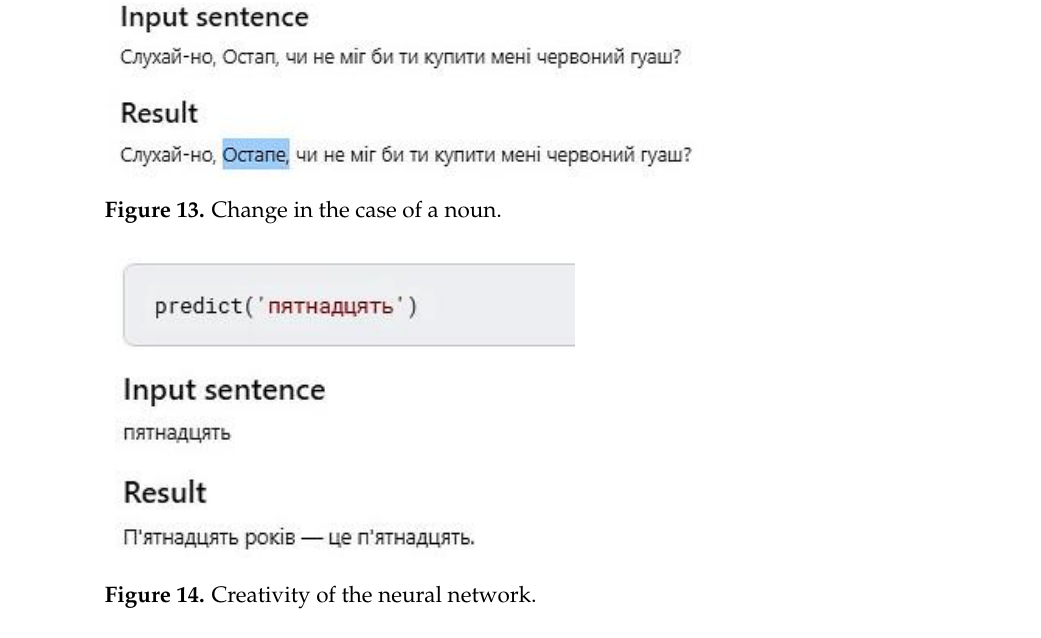
Figure 13. Change in the case of a noun.